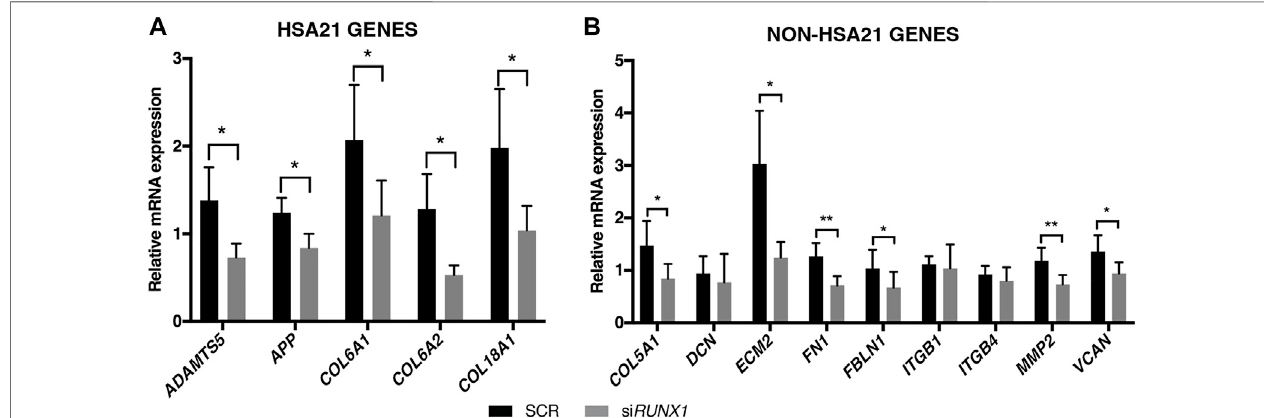
FIGURE4| RUNX1 attenuationdecreasesECMgeneexpressionintrisomic fi broblasts.RelativemRNAexpressionofHsa21 (A) andnon-Hsa21 (B) genescoding for ECM proteins in DS-HFFs transfected with 20 nM si RUNX1 for 72 h. Values represent the average determination from at least 2 qRT-PCR experiments. Results are expressed as relative mean values ± SEM of cell cultures from fi ve SCR and the fi ve corresponding RUNX1 -silenced DS-HFFs carried out in triplicate. * p -value ≤ 0.05, ** p -value ≤ 0.01.